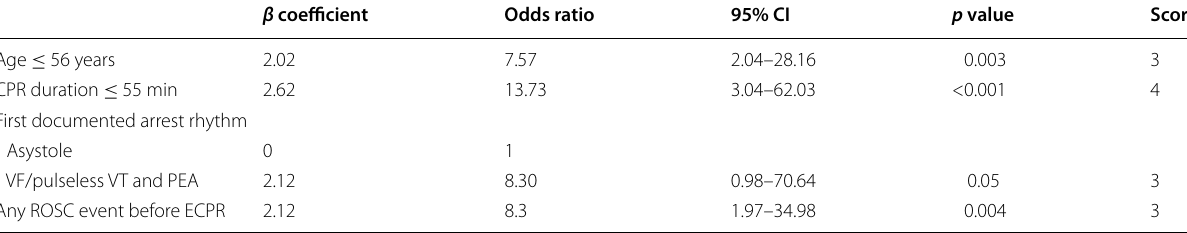
CI Confidence interval, CPR cardiopulmonary resuscitation, VF / VT ventricular fibrillation/pulseless ventricular fibrillation, PEA pulseless electrical activity, ROSC return of spontaneous circulation, ECPR extracorporeal cardiopulmonary